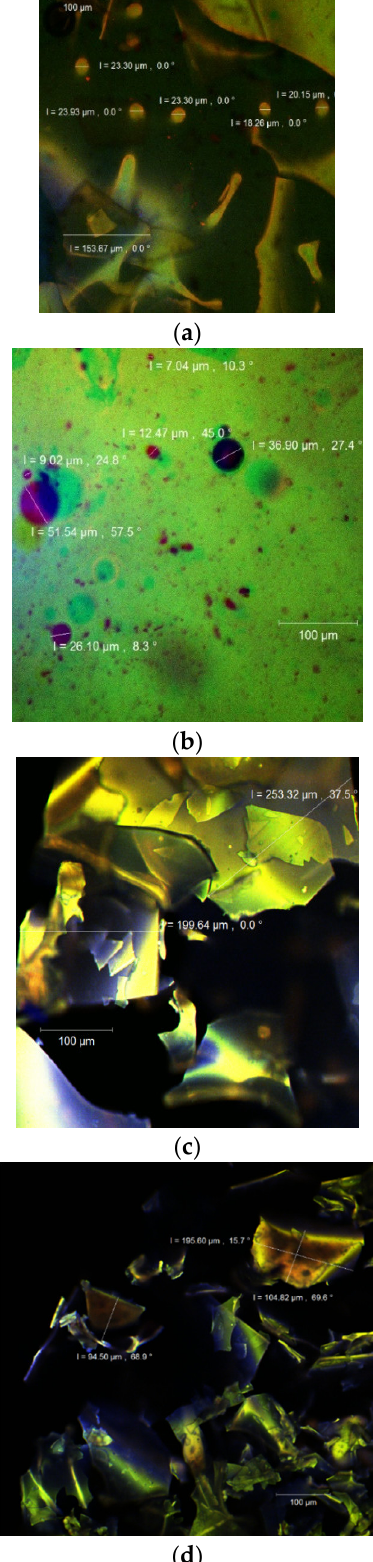
Figure 2. Confocal laser scanning microscopy images of the V1 sample (( a )—native state and ( b )— stained with fluorophores) and V2 sample (( c )—native state and ( d )—stained with fluorophores).